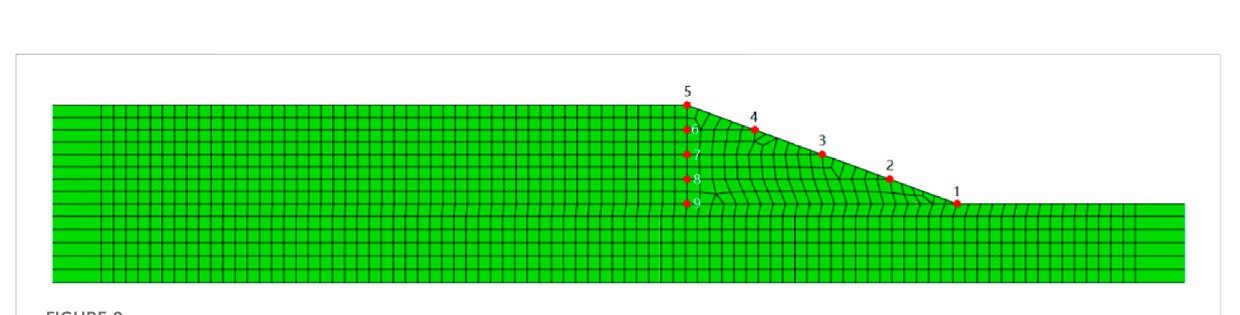
FIGURE 9 Grid division and observation point arrangement of the ground motion parameters of the prototype loess slope.